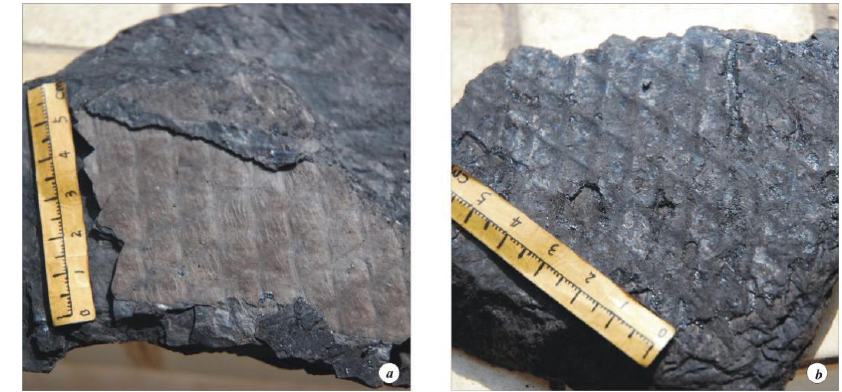
Figure 8. Regular rhombus imprints on the bedding surface of two parts of a Late Permian coal sample from the Liupanshui coalfield: ( a ) the part above the bedding surface; ( b ) the part below the bedding surface.